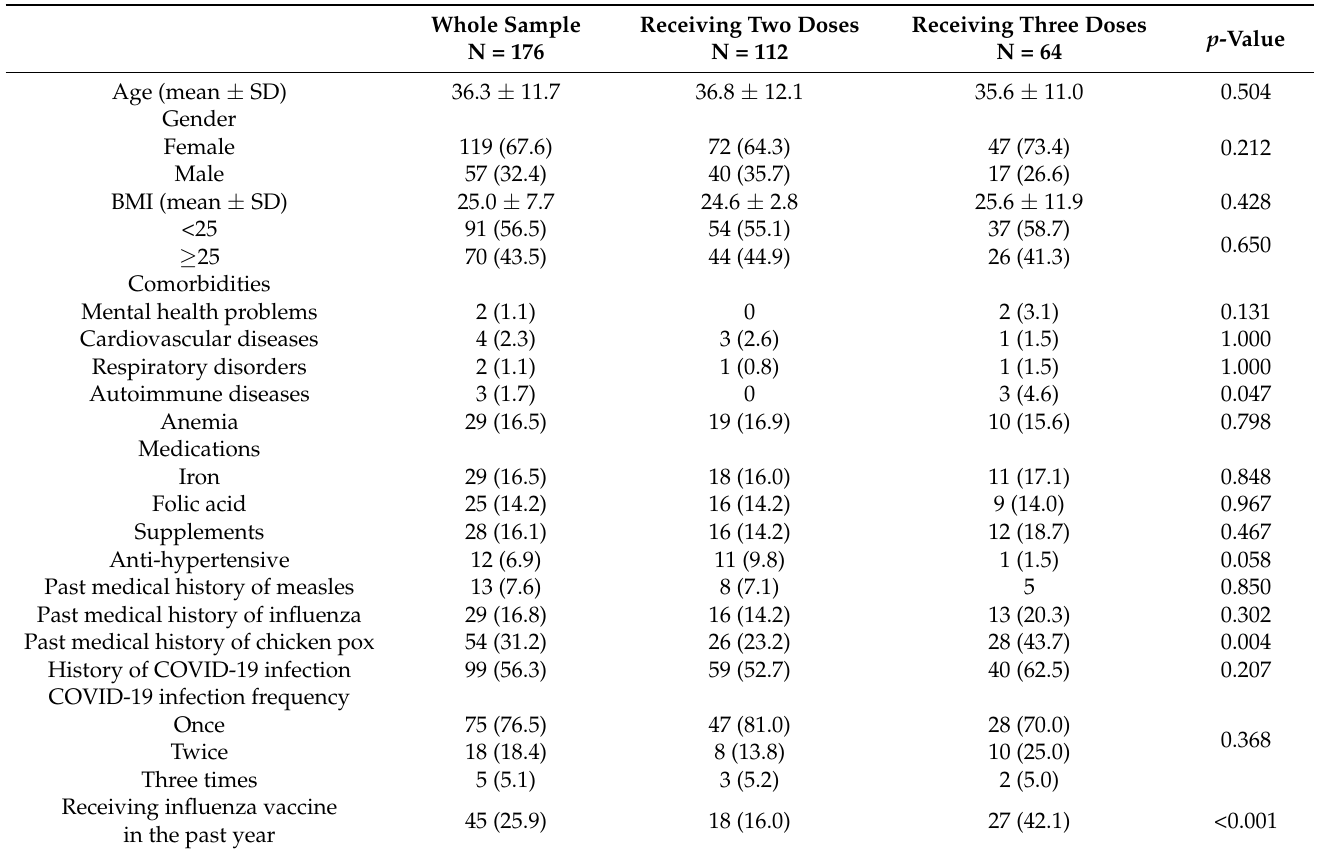
Table 1. Baseline variables of the study population regarding the number of vaccine doses received.